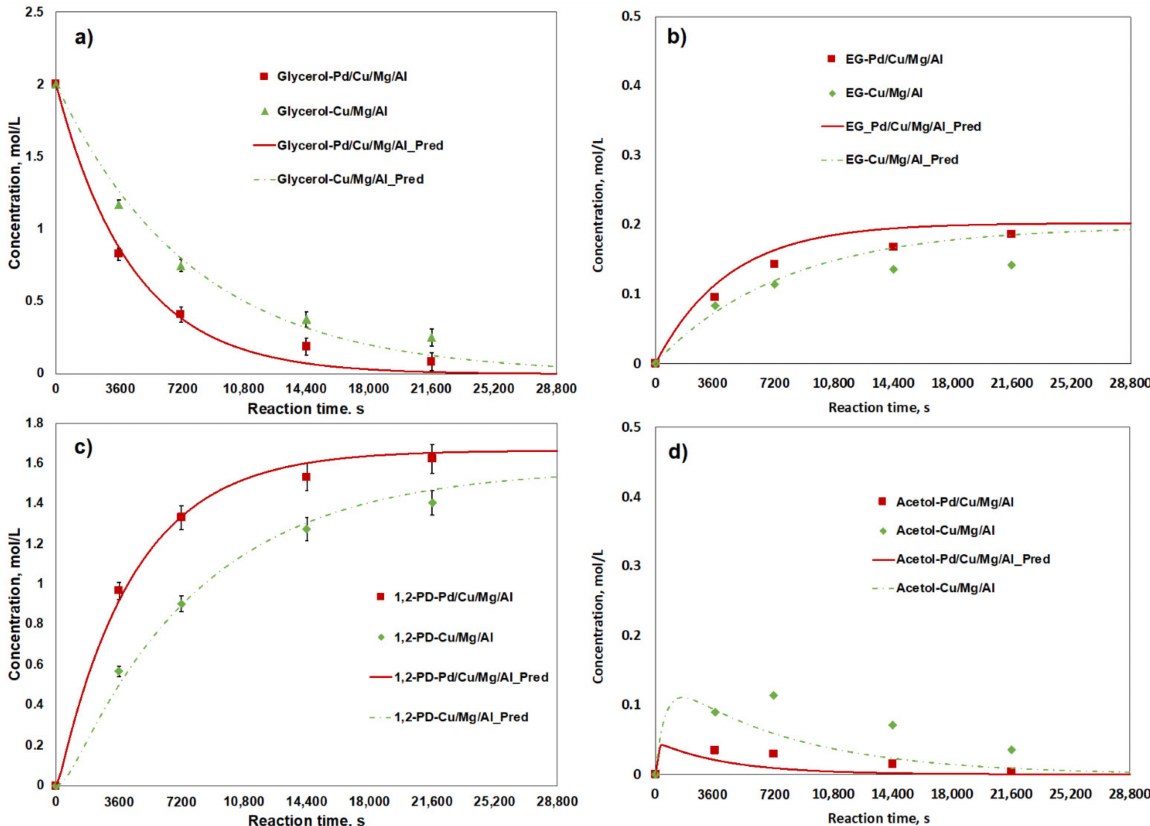
Figure 4. The concentration of different components over the reaction time: ( a ) glycerol, ( b ) EG, ( c ) 1,2-PD, ( d ) acetol. Conditions: 220 ◦ C, 15 bar N 2 , 20 wt% Glycerol, Water/Methanol(molar) = 1.2, 3 wt% catalyst, 500RPM. Error margin: 95% confidence